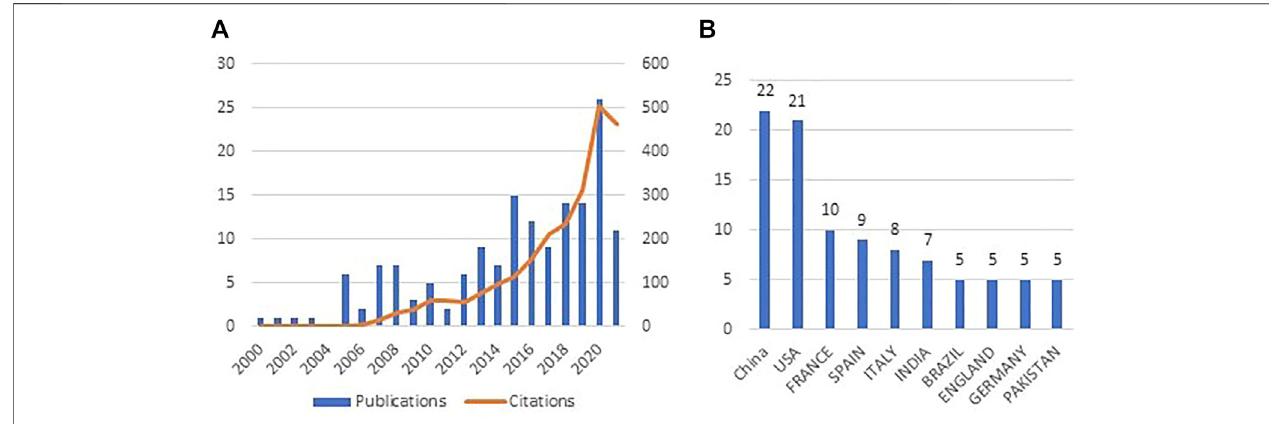
FIGURE1 |(A) Evolution pattern of scienti fi c publication on solar drying ofSS from 2000to2021. (B) Maincountries contributingin scienti fi c production related to solar drying of SS. The keywords used in Web of Science are solar drying, sludge, pathogens, and micropollutants.